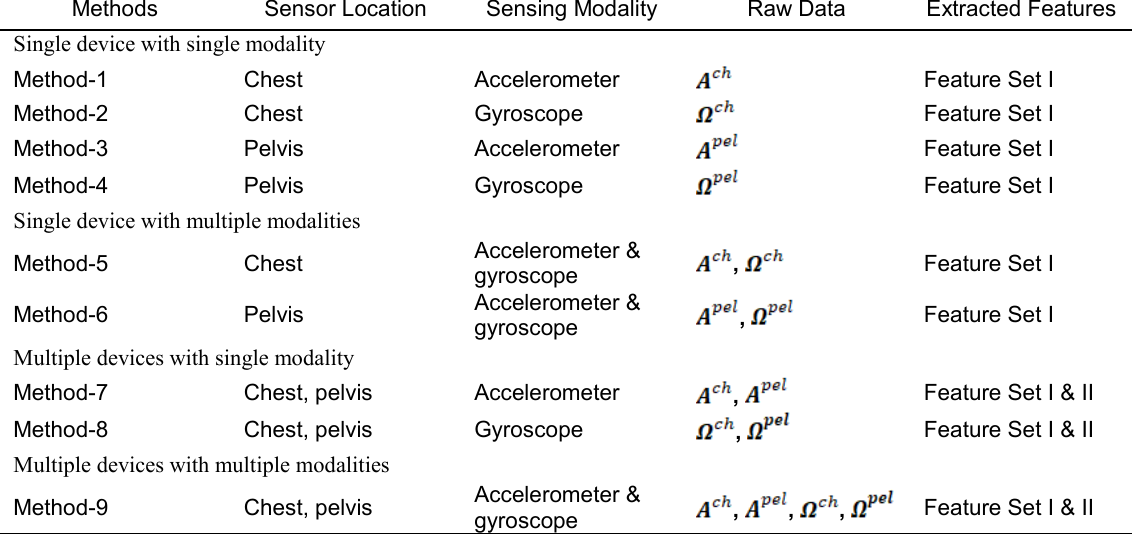
Table 3. Feature extraction for nine methods with varied sensor locations and sensing